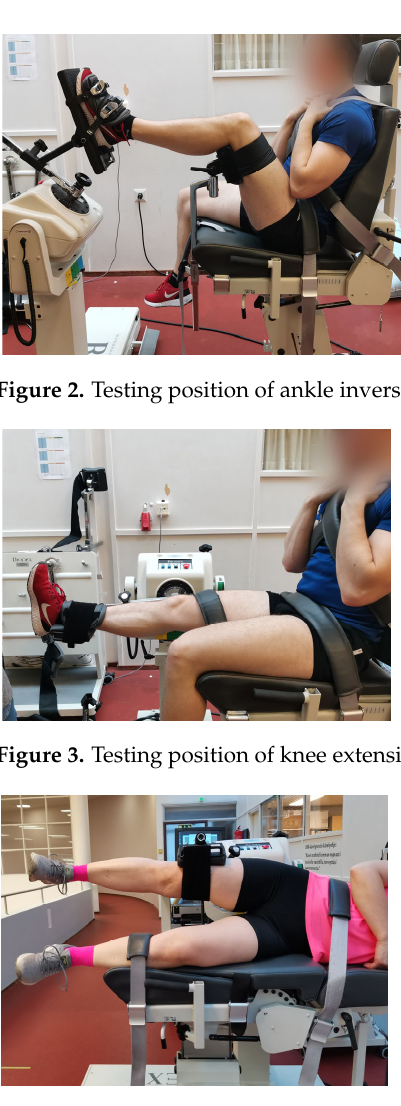
Figure 4. Testing position of hip abduction and adduction.